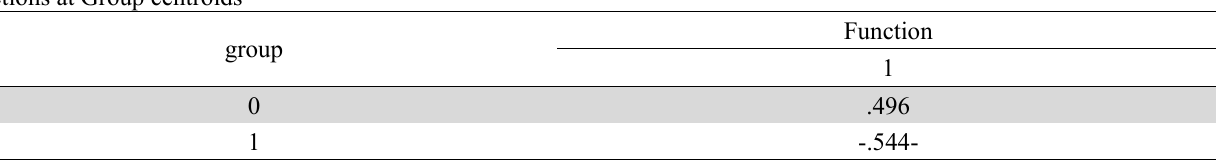
Classification Results